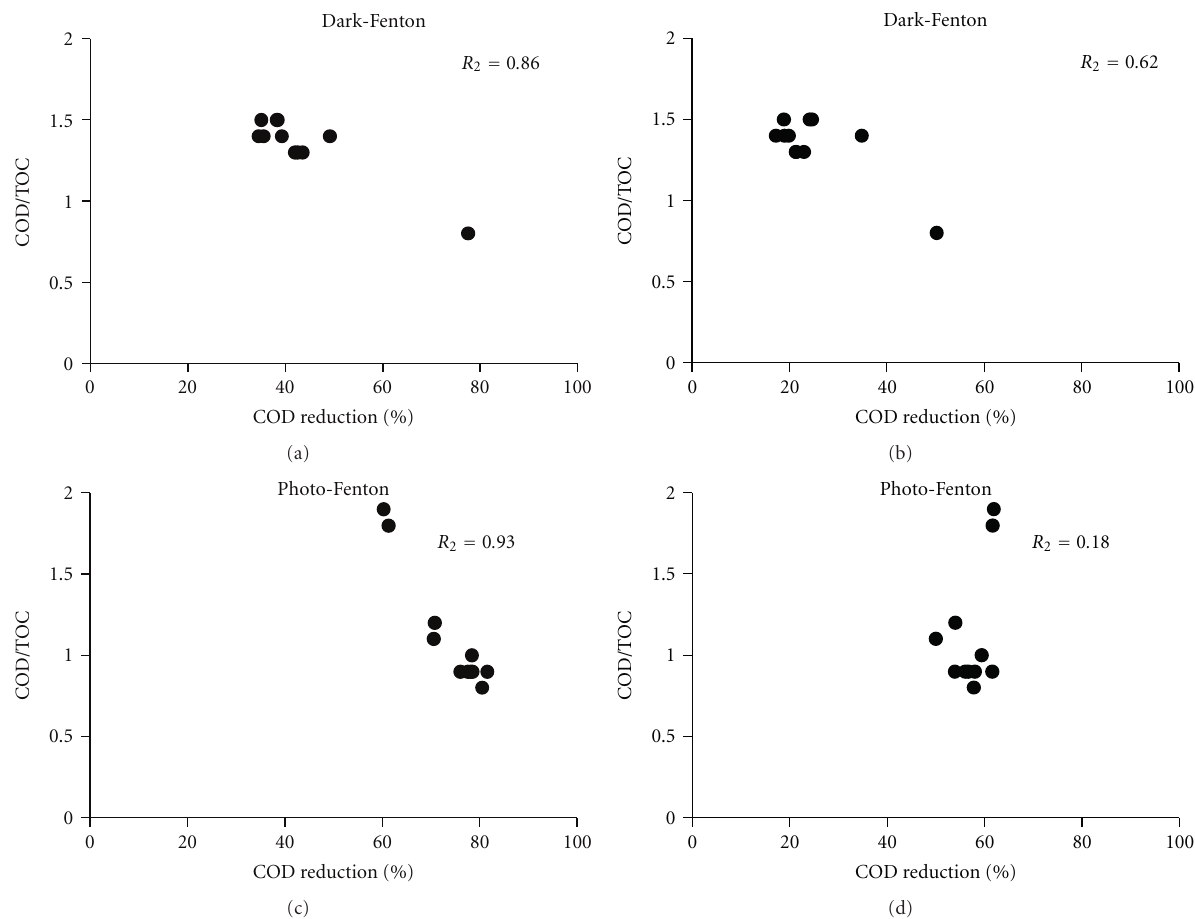
Figure 4: Correlation between COD and TOC reductions (in %) and COD/TOC ratios obtained with di ff erent dark- and photo-Fenton treatment setups.